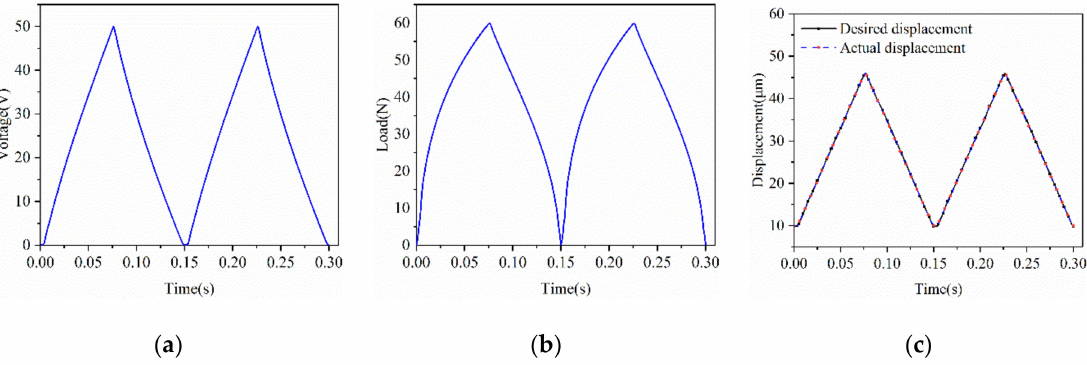
Figure 8. ( a ) The exciting u ( t ) after compensation of the CRPI model; ( b ) The exciting F ( t ) after compensation of the CRPI model; ( c ) Actual displacements of the CRPI model after compensation and desired